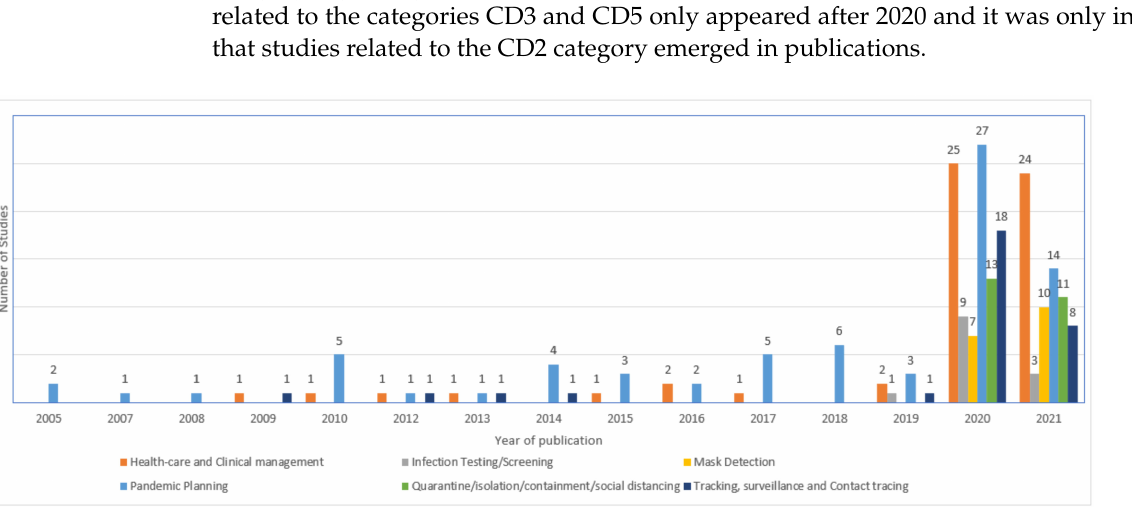
Figure 5. Distribution of studies by application domain and year of